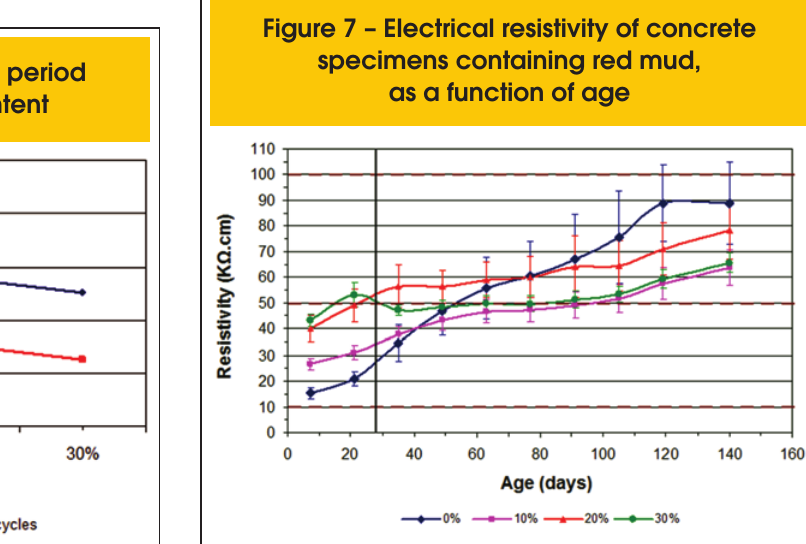
Figure 5 – Rebar corrosion onset period as a function of red mud content